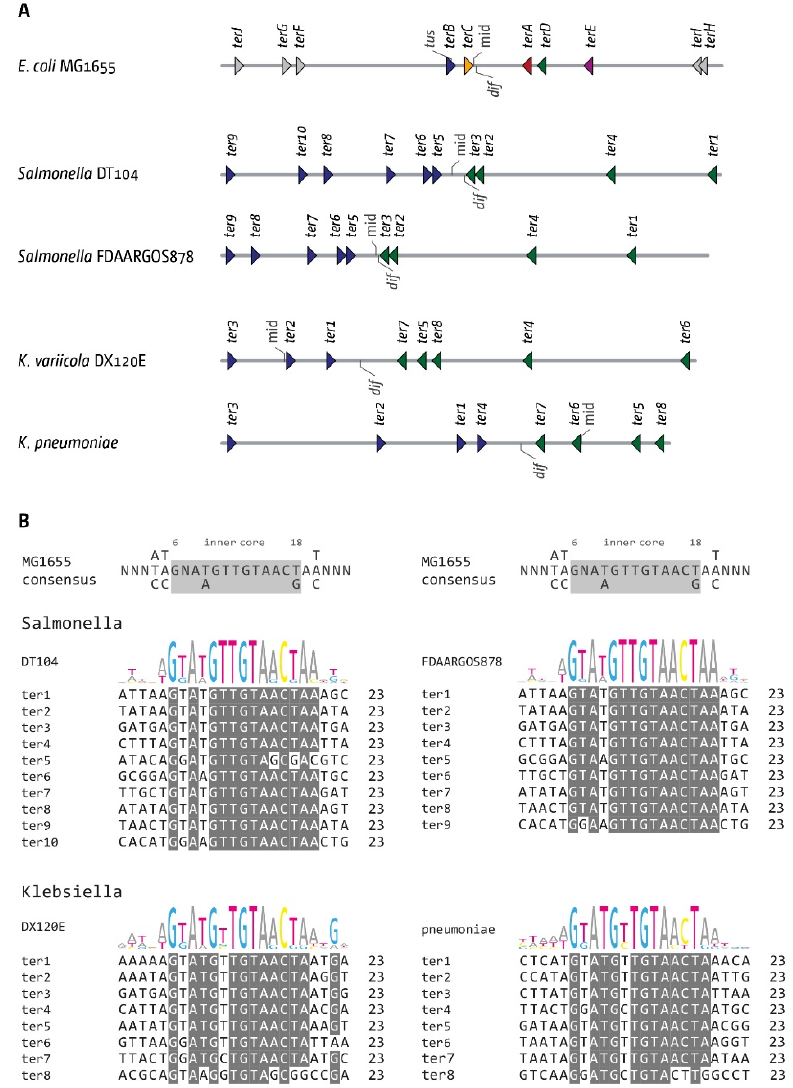
Figure 8. The replication fork trap in Salmonella and Klebsiella genomes. ( A ) Architecture of the replication fork trap in two Salmonella enterica genomes, as well as Klebsiella variicola and K. pneumoniae . The organisation of the E. coli ter sites is shown at the top as reference. All ter sites identified, as well as the chromosome dimer resolution site dif , are indicated by markers. The orientation of the ter sites are indicated by the direction of the triangle (forks encountering the tip of the triangle would get blocked). All ter sites identified were numbered, as the relationship to the ter sites in E. coli is not clear. ( B ) Sequence comparison of all ter sites from the two Salmonella enterica , the Klebsiella variicola and the K. pneumoniae genomes. The ter consensus sequence derived from MG1655 is shown at the top for reference purposes. All base pairs that are identical are shown by a grey background.